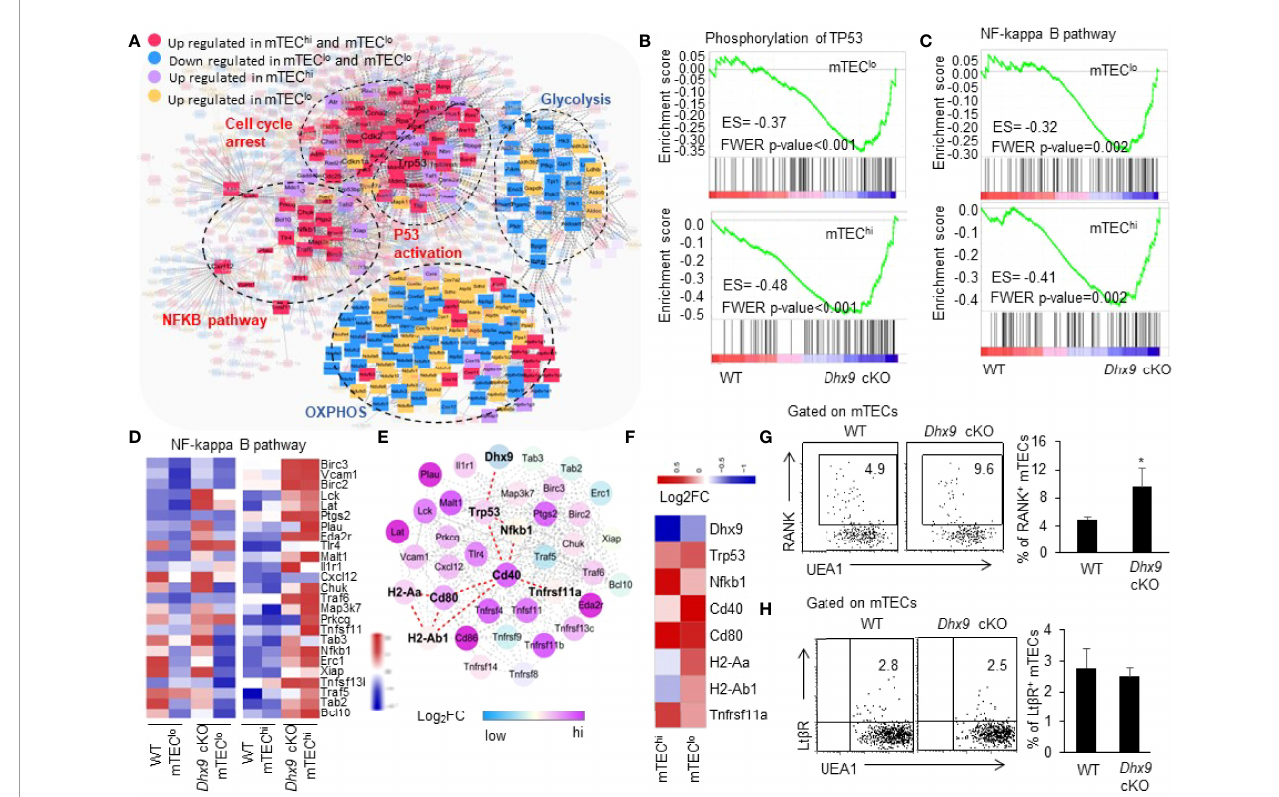
FIGURE 7 | TEC-speci fi c inactivation of Dhx9 leads to over-activation of NF- k B signaling pathways in a P53-dependent manner. (A) The molecular network associated with P53. (B) GSEA exhibited an enrichment of the phosphorylation of the TP53 gene set in Dhx9 -de fi cient mTEC lo and mTEC hi , as de fi ned by the criterion P < 0.05. (C) GSEA exhibited an enrichment of the NF- k B signaling pathway in Dhx9-de fi cient mTEC lo and mTEC hi , as de fi ned by the criterion P < 0.05. (D) Heatmap of the signi fi cantly changed genes ( p < 0.05) associated with the NF- k B signaling pathway in mTEC lo and mTEC hi from WT and Dhx9 cKO mice. (E) The molecular network between the P53 and NF- k B pathway associated with upregulated genes. (F) The heatmap showed log 2 FC of indicated genes in Dhx9 de fi ciency in mTEC lo and mTEC hi , compared with the WT control. (G) Representative fl ow cytometric plots and frequencies of RANK + mTECs from 4-week-old WT ( n = 4) and Dhx9 cKO mice ( n = 5). * P < 0.05, (student ’ s t -test). (H) Representative fl ow cytometric plots and frequencies of Lt b R + mTECs from 4-week-old WT and Dhx9 cKO mice ( n = 4 for each group). * P < 0.05, (student ’ s t